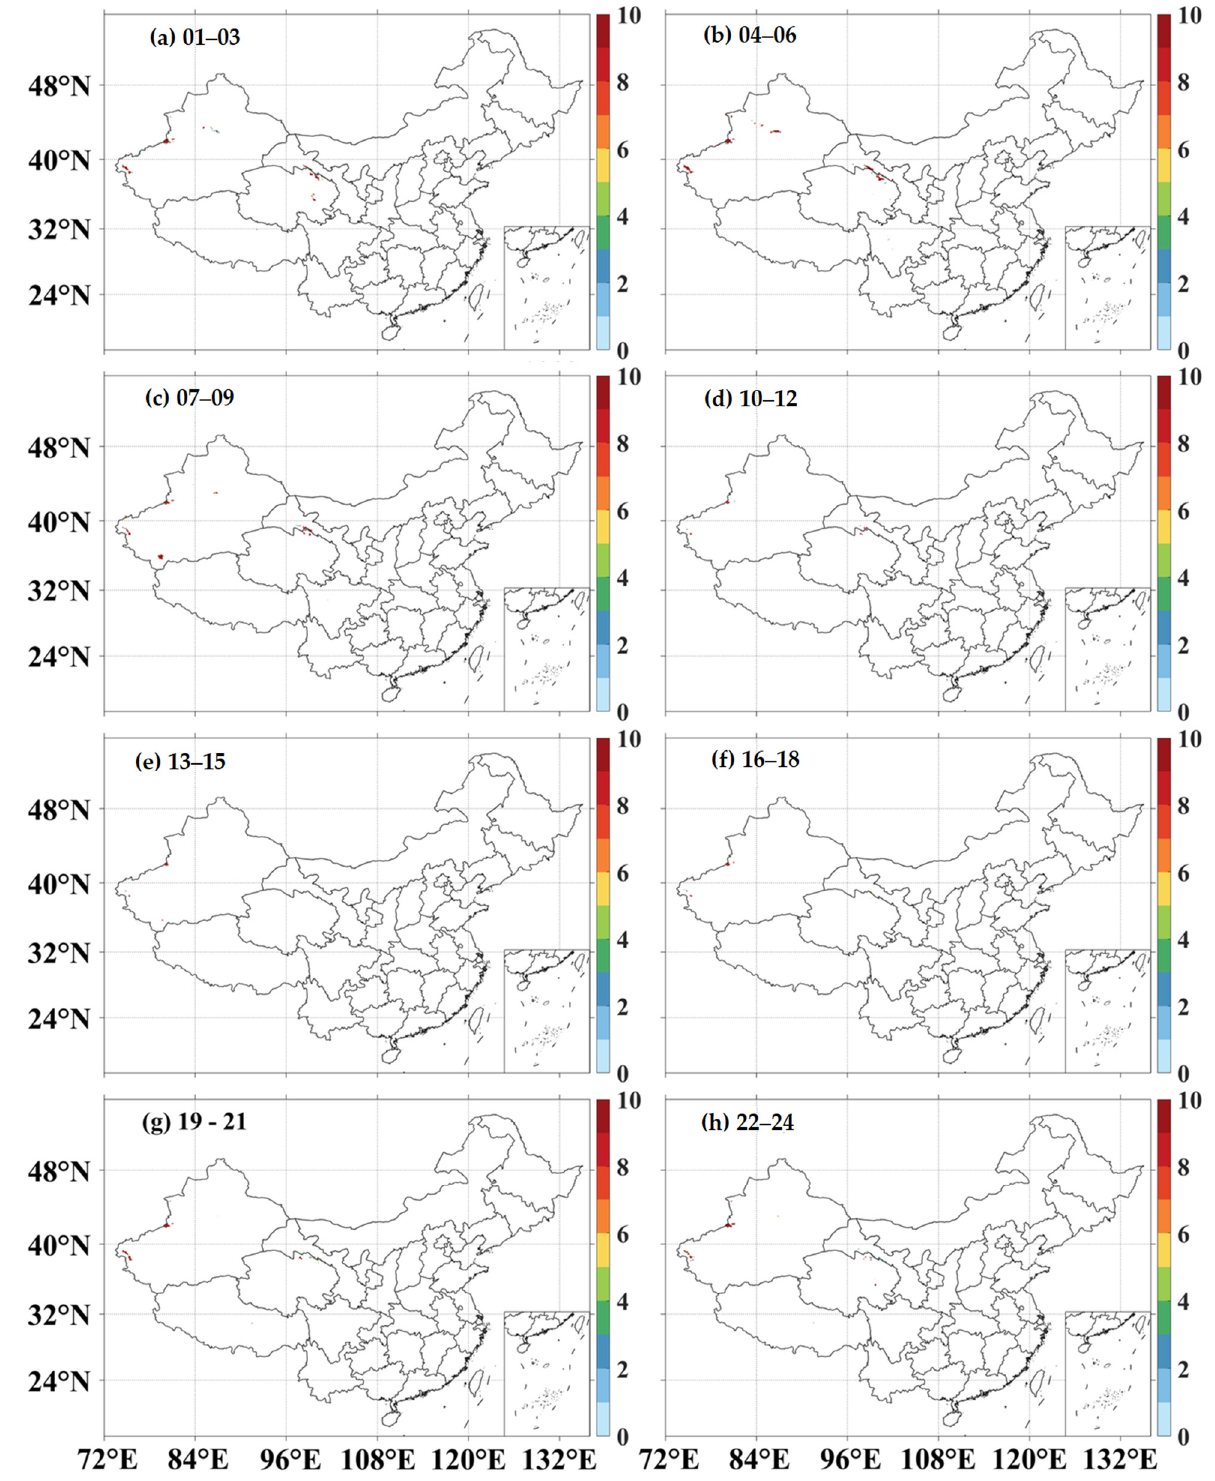
Figure 15. Diurnal variation of frequency (%) distribution of snow for period LST 01–03, 04–06,